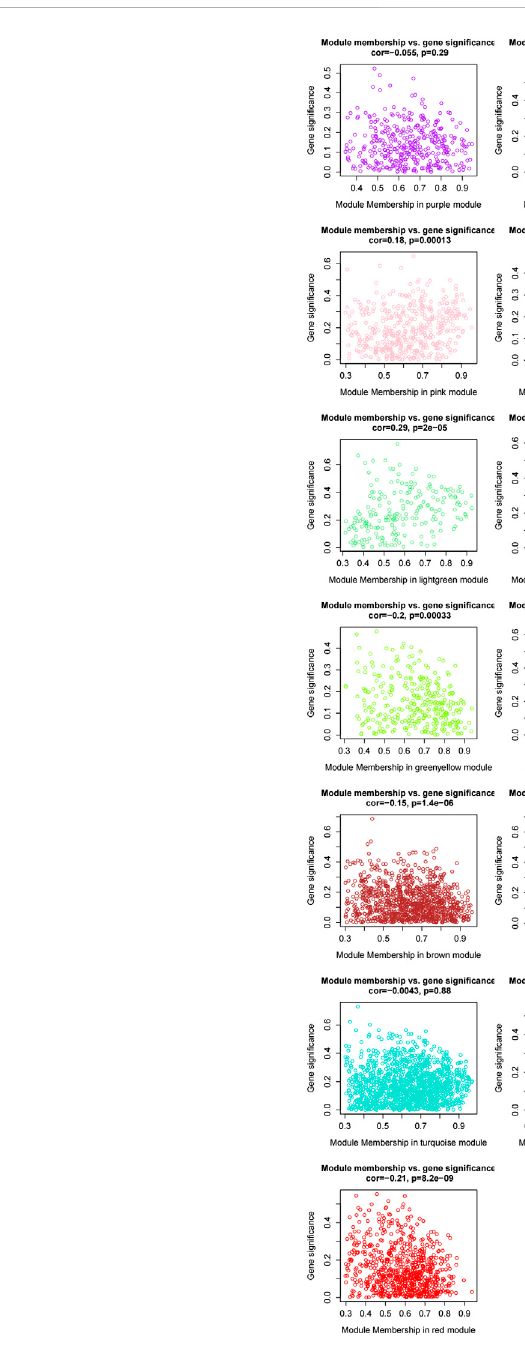
FIGURE 6 Distribution of gene signi fi cance in each